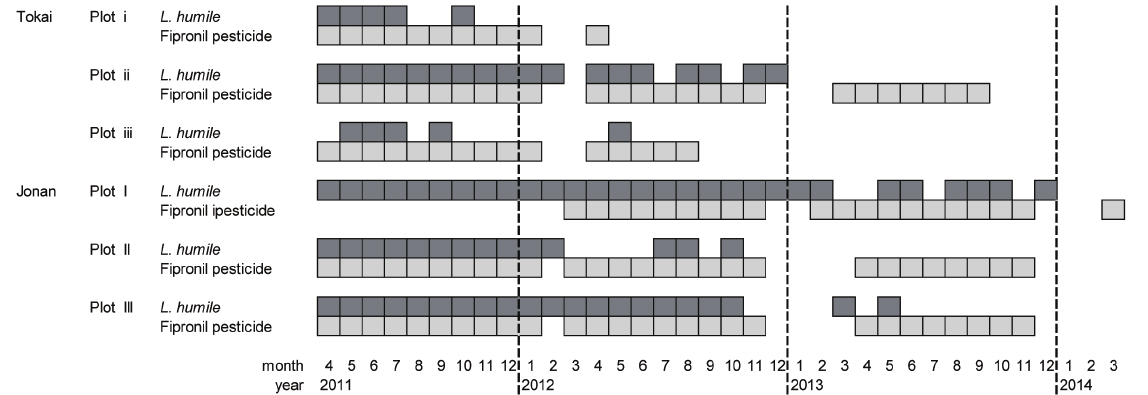
Fig 2. Presence of Linepithema humile and fipronil pesticide use history in each plot at Tokai and Jonan over 3